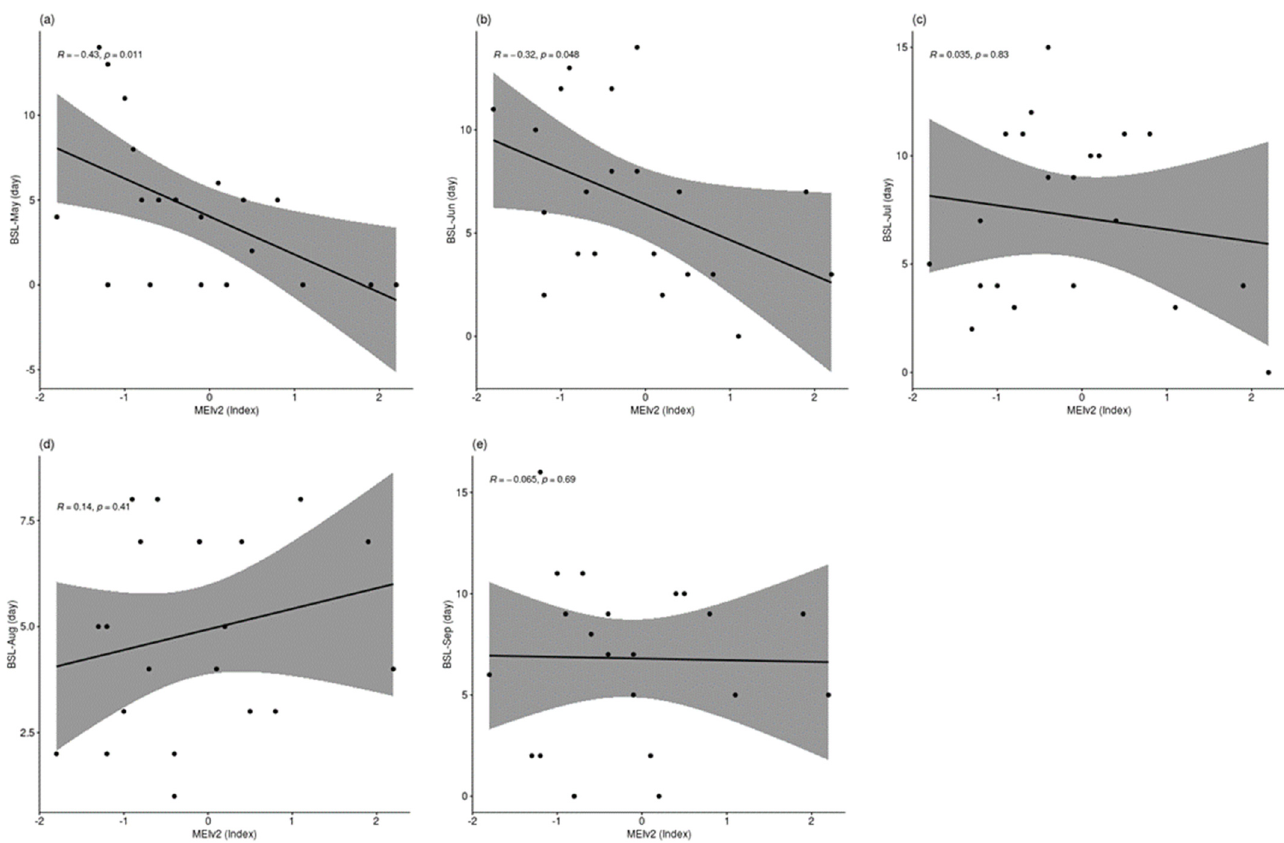
Figure 11. Correlation coefficient between BSL days and the SST anomalies (°C) during ( a ) January– March, ( b ) March–May, and ( c ) May–July. Areas significant at 0.05 level are hatched.